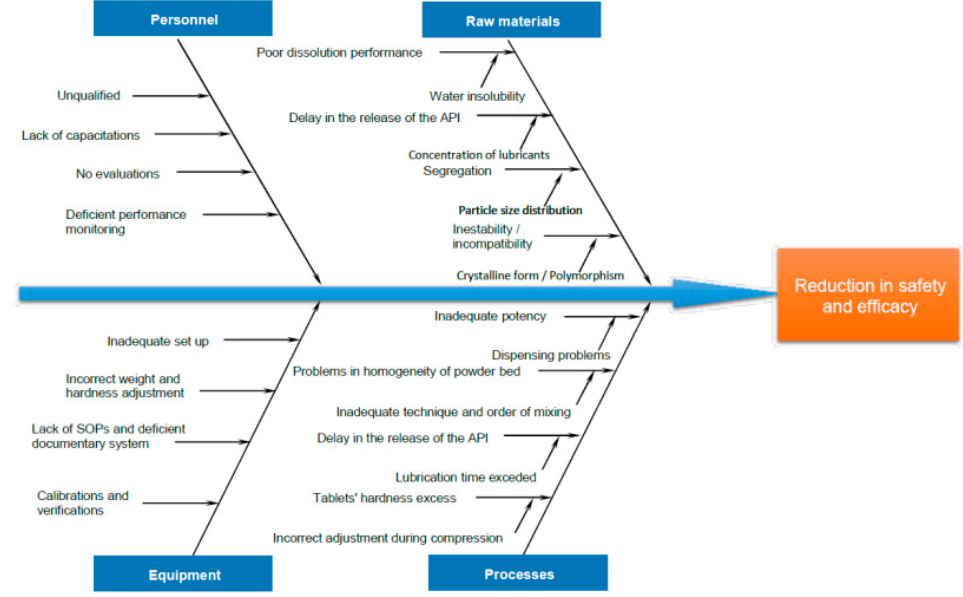
Figure 2. Example of an Ishikawa diagram for risk management in Formulation Development carried out in the Academy. Reprinted with permission from Castillo, L. et al. Drug Development and Industrial Pharmacy , 45(10). Copyright (2019) Taylor & Francis [44].